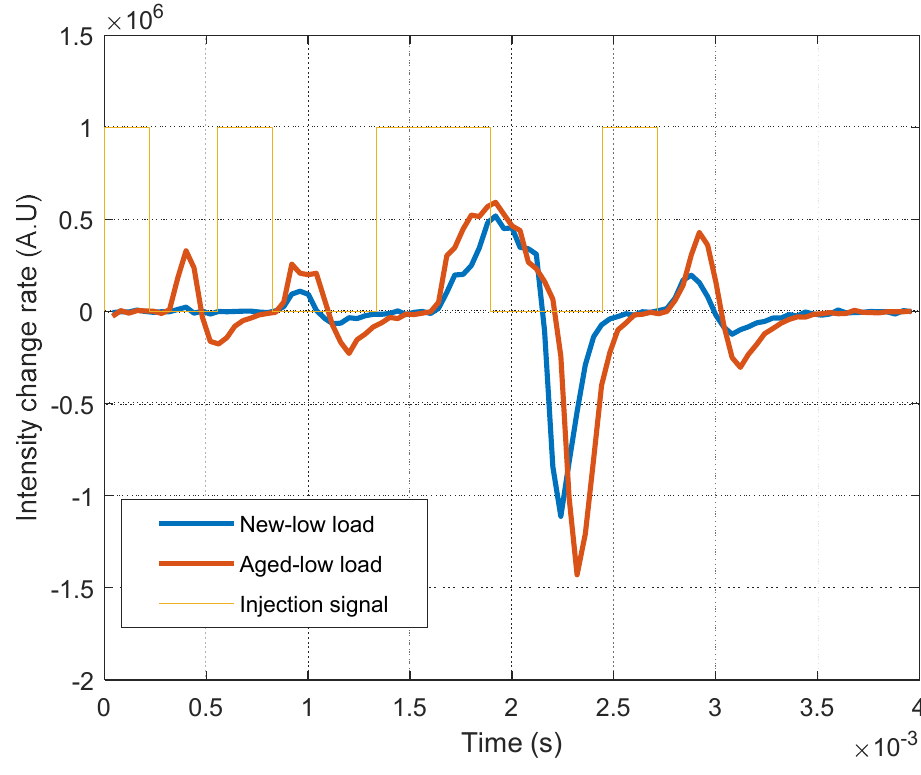
Figure 7. Total scattering signal change rate at low load.